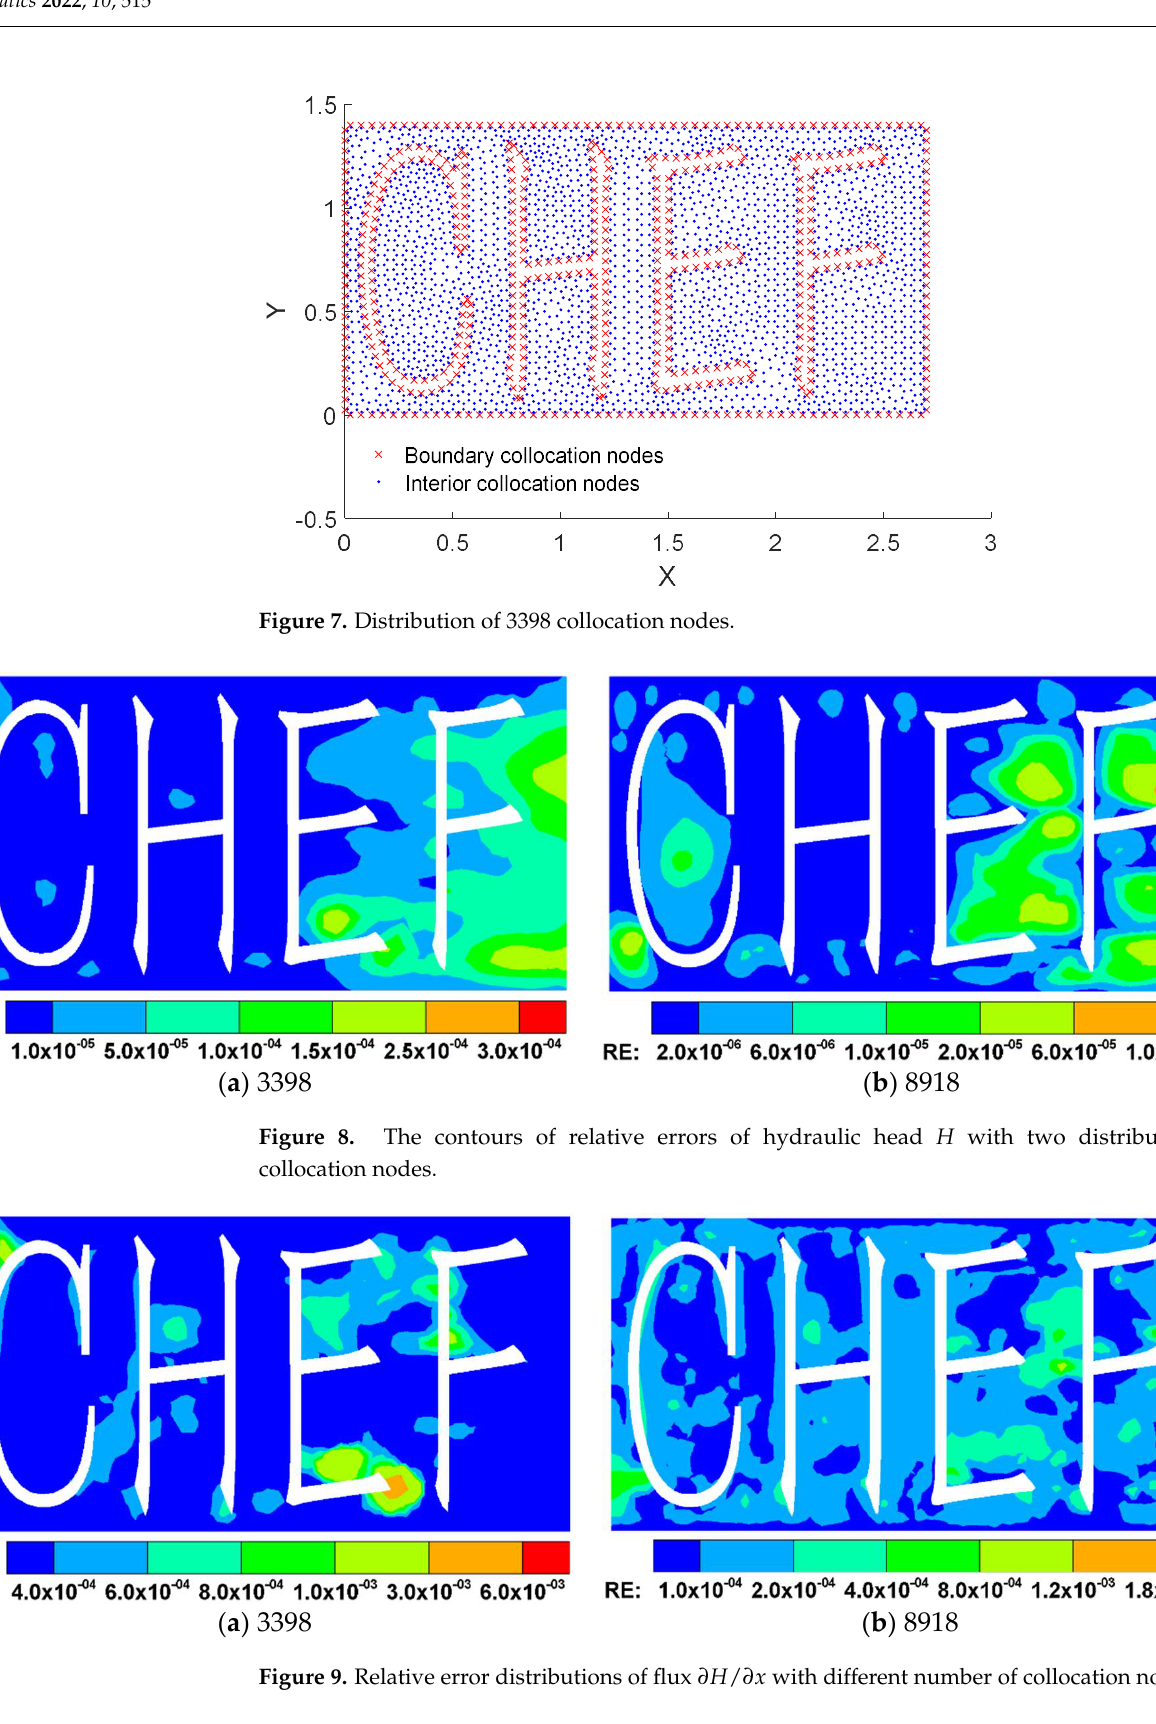
Figure 9. Relative error distributions of flux / H x   with different number of collocation nodes.